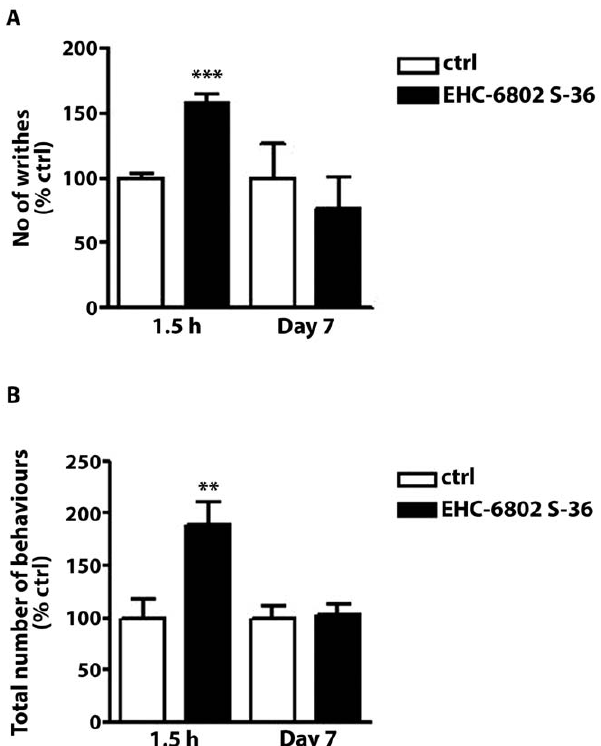
Figure 3. The effect of EHC-6802 (360 m g/200 m l/animal, p.o.) on behavioural pain responses in mice. A) The effect of EHC-6802 in the writhing test in mice. The number of writhes was determined 5 min after acetic acid injection (0.5%, 10 ml/kg, i.p.) over a period